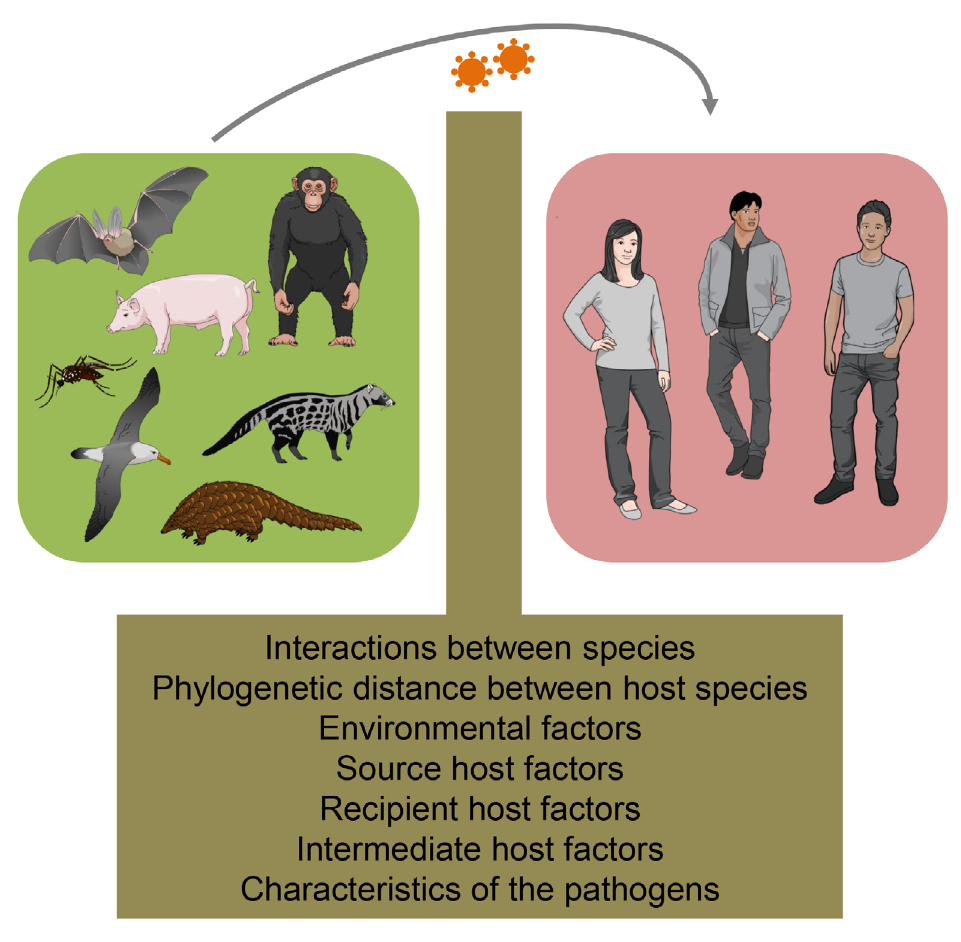
Figure 1 – Factors between wildlife, livestock animals and humans. The intensity and frequency of interactions between species, the phylogenetic distance between host species, characteristics of the pathogens, source host-associated factors, recipient host-associated factors, environmental factors, and intermediate host-associated factors (when this particular host is present) can hinder or facilitate the transmission of pathogens from wild animals/ livestock to the human population. The zoonotic spillover occurs when these factors are favorable to the pathogen, allowing the crossing of barriers between species. This figure was created using Mind the Graph illustrations (available at